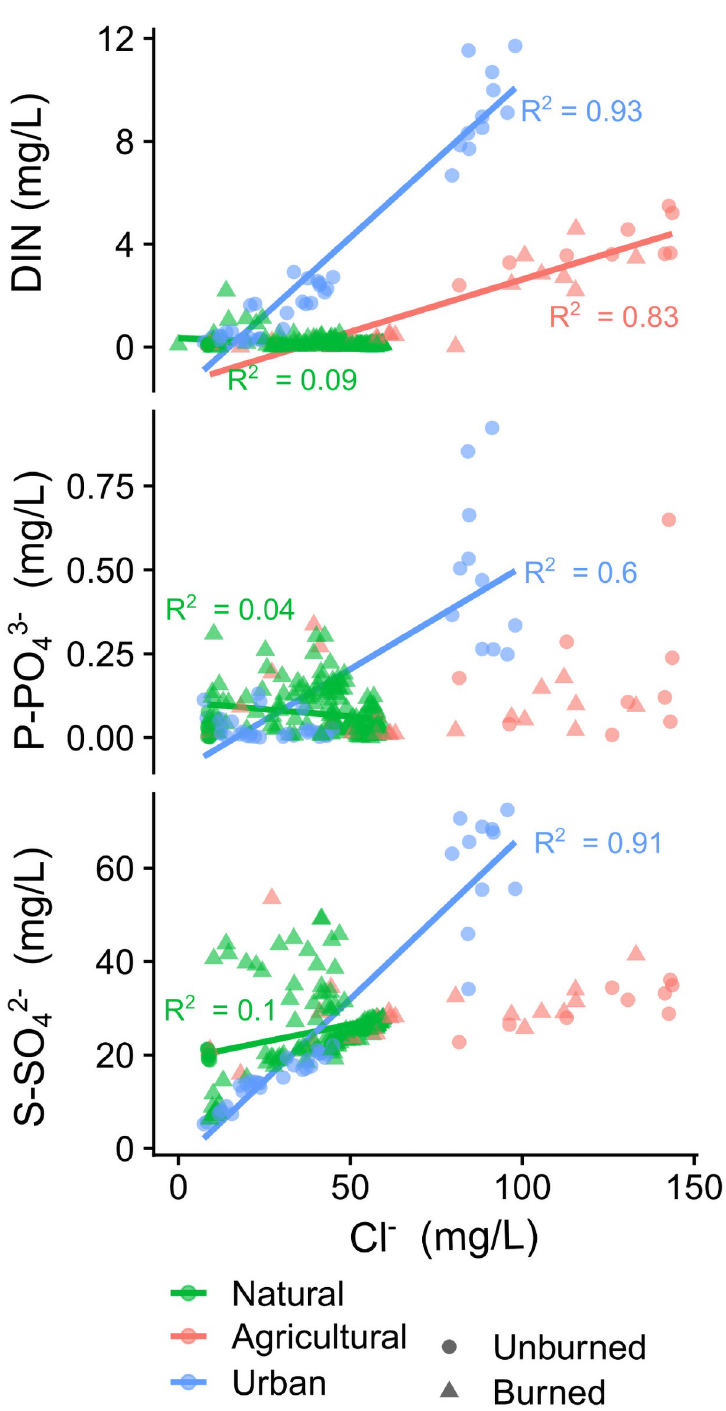
Fig 4. The relationship between chloride (Cl - ), a common indicator of human activity and inorganic nutrients in natural, agricultural, and urban watersheds. Circles and triangles represent unburned and burned watersheds,